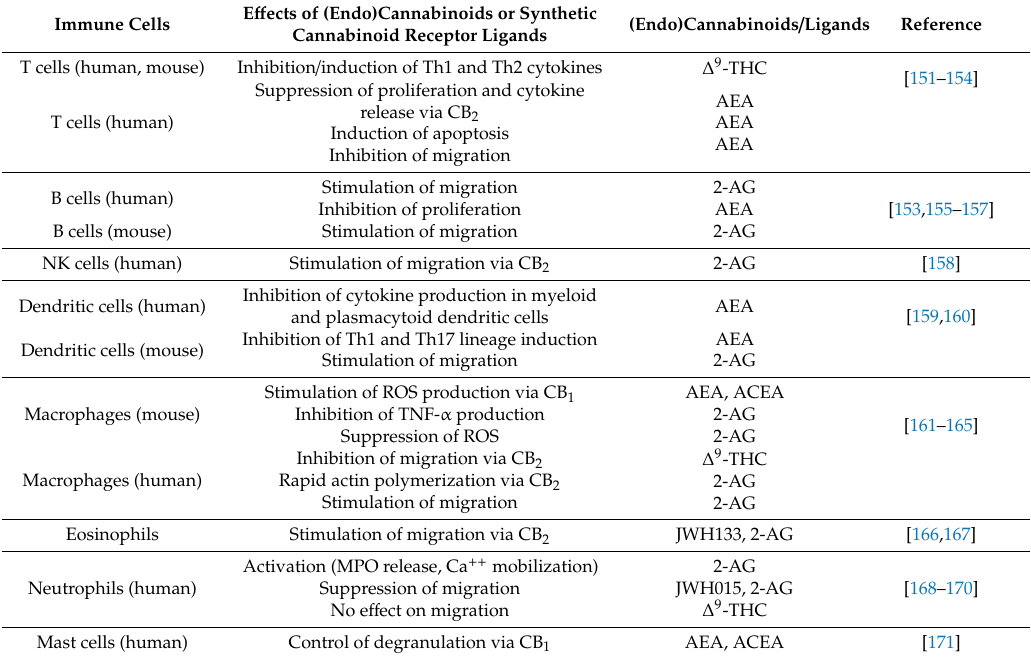
Table 1. Some main actions of (endo)cannabinoids and cannabinoid receptor ligands on immune cells. E ff ects of (Endo)Cannabinoids or Synthetic Immune Cells (Endo)Cannabinoids / Ligands Cannabinoid Receptor Ligands